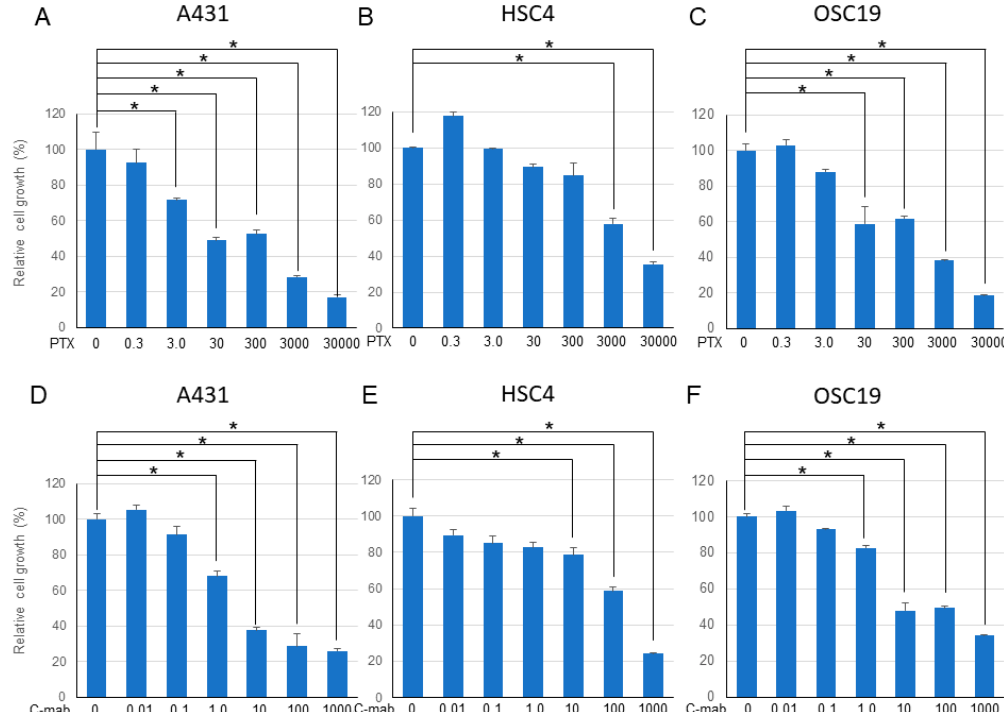
Figure 1. 48 h after treatment. Relative cell growth with PTX treatment of each cell lines ( A – C ), or with C-mab treatment ( D – F ) are shown. Statistical analysis was performed by one-way ANOVA with Tukey’s multiple comparison test as a post hoc analysis. *: p < 0.05. The values shown are the mean of three determinations; bars: standard error of the mean. The data shown is a representative from three independent experiments with similar results.